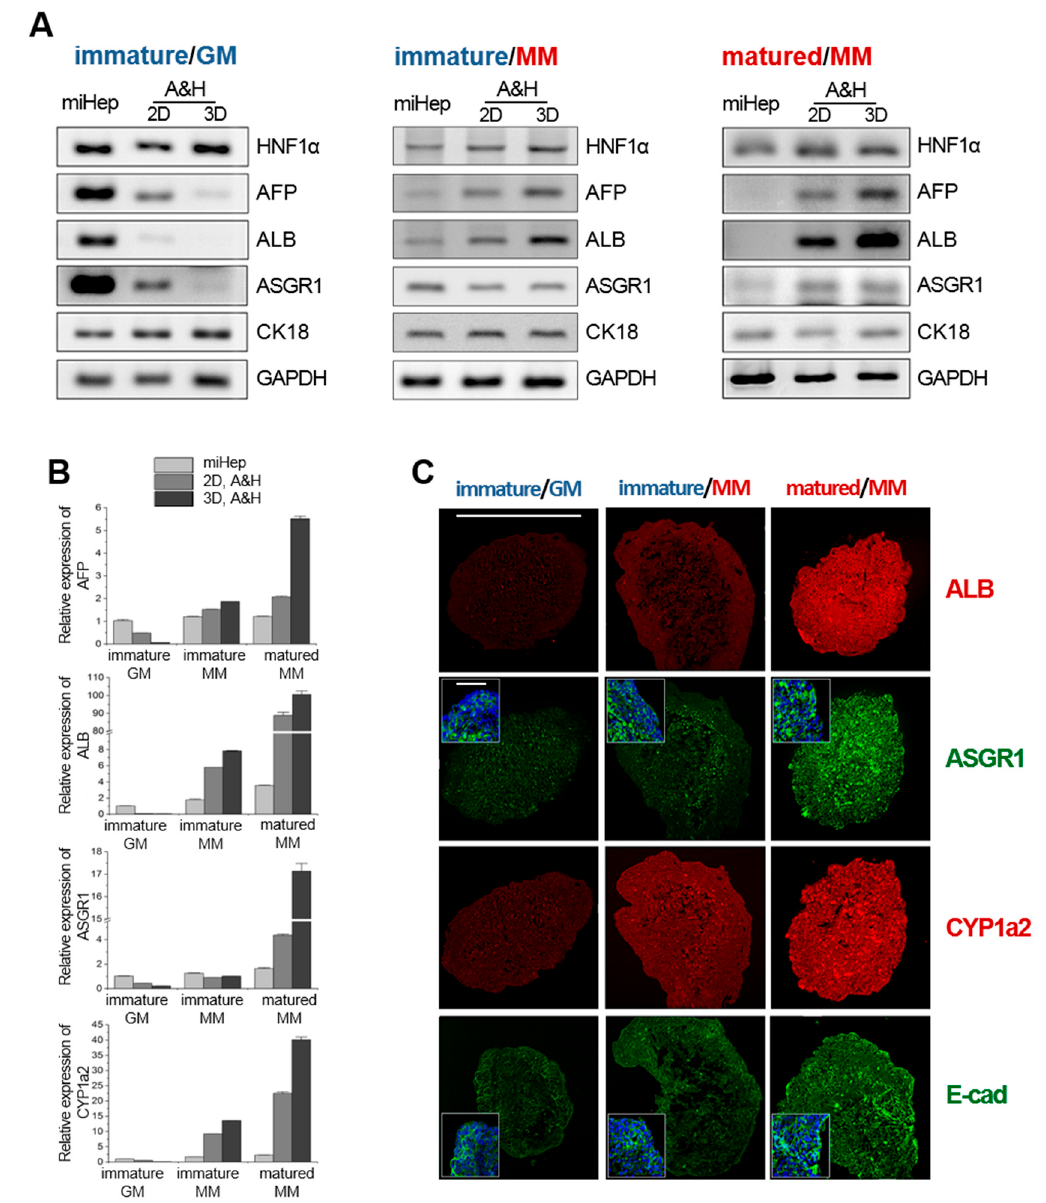
Figure 3. Effects of hASC co-culture on the hepatic function of hASC-miHep co-spheroids. ( A ) Reverse-transcription PCR and ( B ) quantitative real-time PCR analysis of miHeps and hASC-miHep co-spheroids; miHeps, 2D-cultured miHeps; immature, immature miHeps; mature, mature miHeps; GM, growth media; MM, maturation media. ( C ) Immunostaining analysis of co-spheroids (scale bar: 500 µ m). The enlarged image distinguishes the membrane proteins (ASGR1 and E-cad; green) and nuclei (DAPI; blue) (scale bar: 50 µ m). All measurements were taken 48 h after inducing spheroid formation.